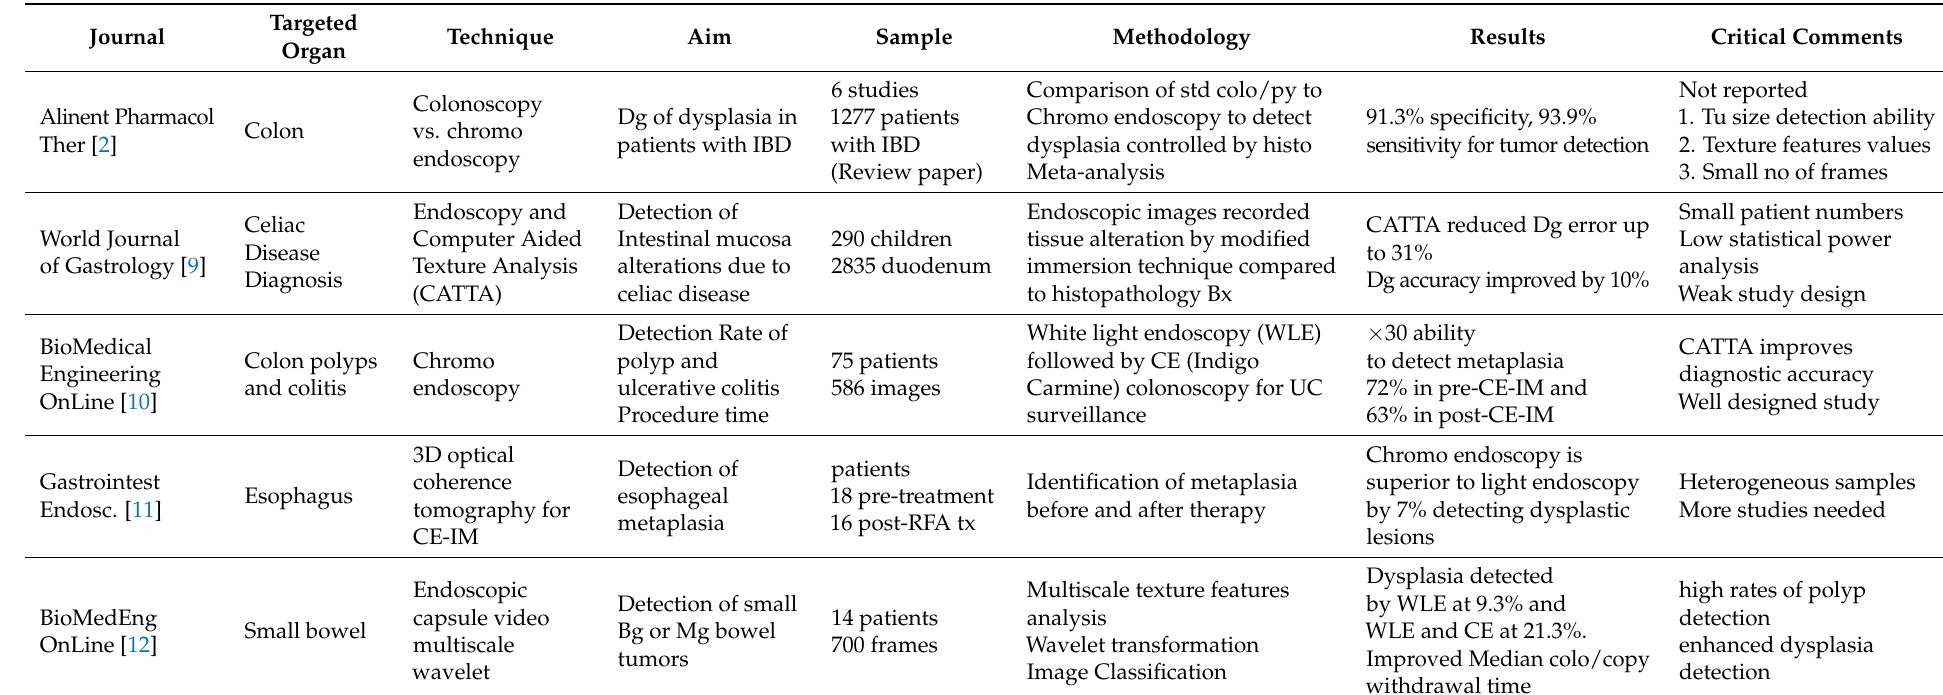
Table 3. CATA used in endoscopic procedures for the Gastrointestinal